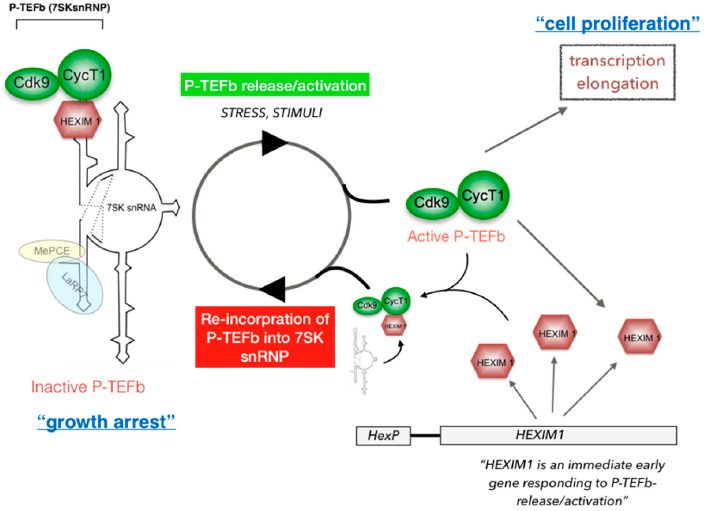
Figure 2. P-TEFb regulatory mechanism. In cells, most P-TEFb molecules are incorporated into 7SK snRNP which contains 7SK snRNA, HEXIM1, MePCE, and LARP7. In 7SK snRNP, the CycT1 subunit directly binds to the central loop of 7SK snRNA and HEXIM1, which inhibits the kinase activity of Cdk9. Various stimuli including stress, environmental stimuli, cytokine signaling, PKC activation, and treatment of cells with HDACis, BETis, and other compounds release P-TEFb and stimulate Cdk9 kinase activities. Released (free) P-TEFb can subsequently be recruited to RNAPII early elongation complex paused at the promoter proximal regions of many cellular genes that drive cell proliferation. One of P-TEFb’s target genes immediately responding to P-TEFb release / activation is its own inhibitor cell growth